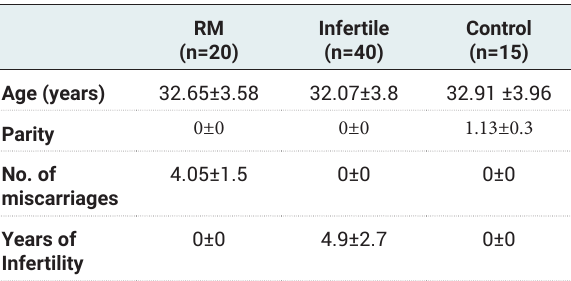
Table 1: Patients’ characteristics among study